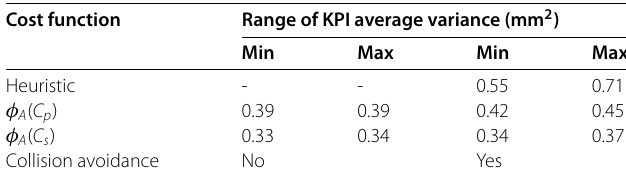
Table 7 Minimum and maximum value of the averaged three dimensional variances of the tool center point (mm 2 ) from the 90 experiments with heuristic and optimized experimental design for parameter identification Cost function Range of KPI average variance (mm 2